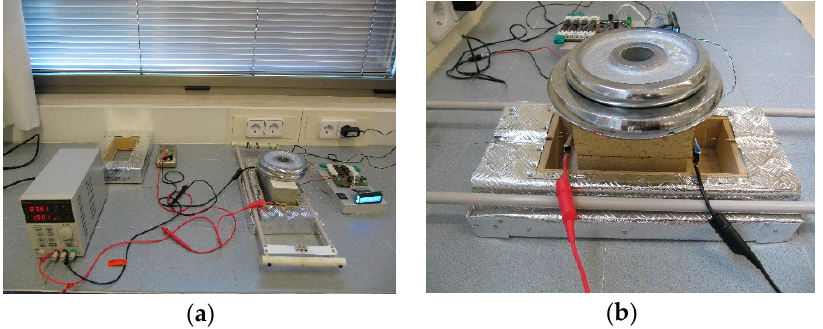
Figure 3. MCT. ( a ) General view; ( b ) Detail view.